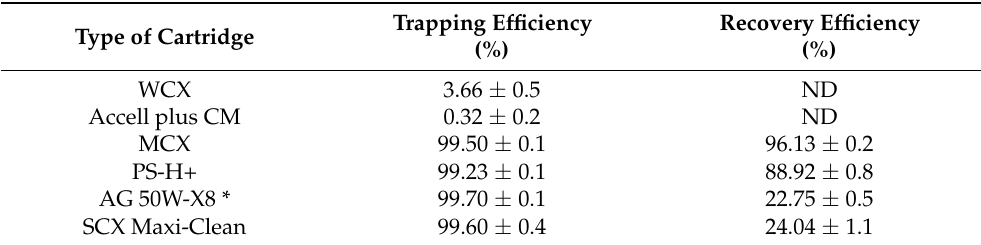
Table 1. Comparison of 68 Ga 3+ trapping and recovery efficiencies with 136 mM solution of sodium citrate from different solid supports ( n = 3).